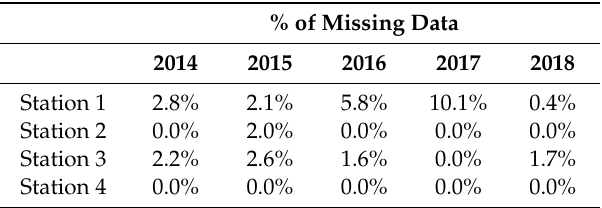
Table 2. Percentage of missing data for each station from 2014 to